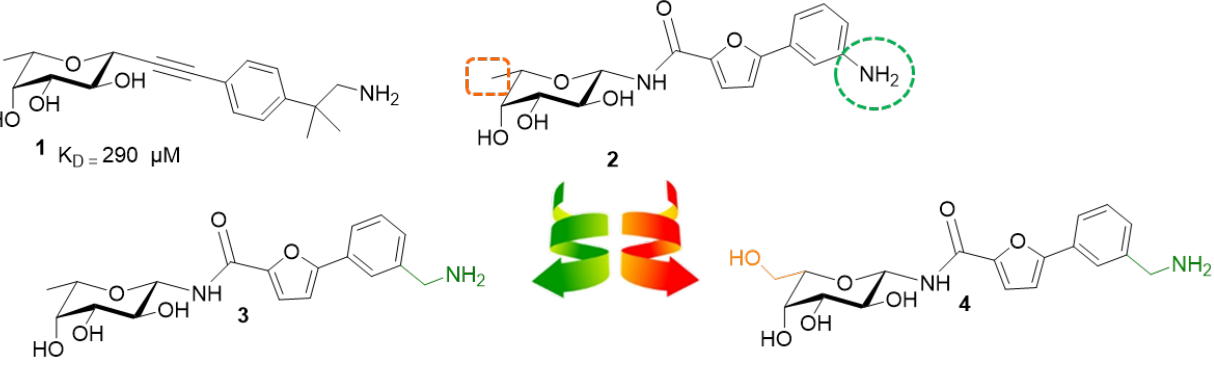
Figure 1. The BC2L-C-Nt ligand 1; the water-insoluble amide 2 was found to occupy the same binding region as 1 in the X-ray of a complex obtained by ligand exchange in the crystal, but its affinity could not be measured [8]. Ligands 3 and 4 described in this paper are water-soluble analogs of 2 .